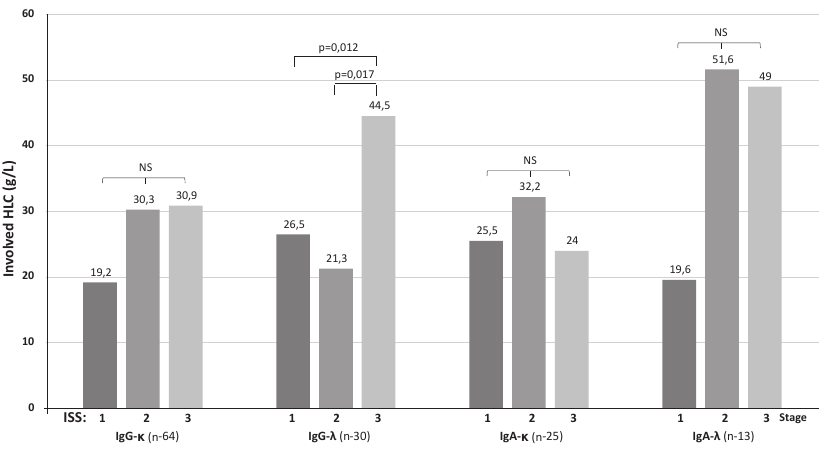
Fig.3. Comparison of medians of serum levels of involved HLC to the stage 1-3 of multiple myeloma assessed using International Staging System (ISS) with regard to κ and λ types in the group of IgG and IgA multiple myeloma